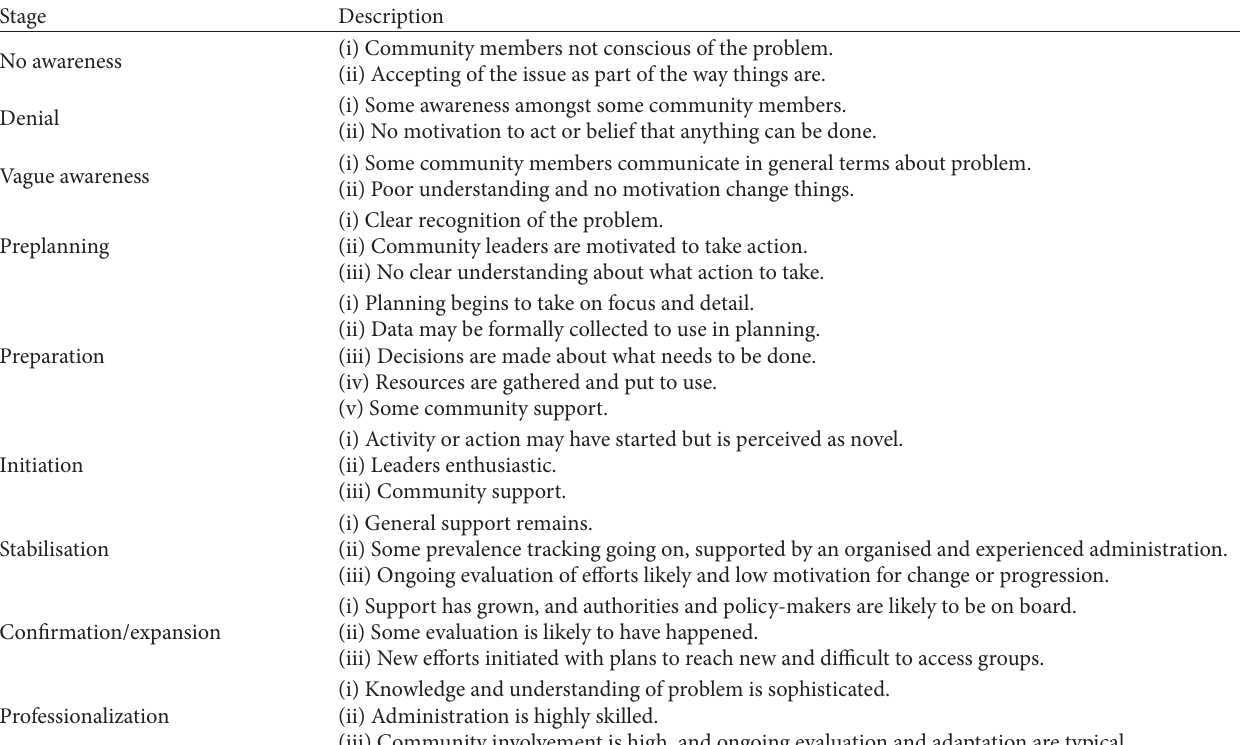
Table 1: Stages of community readiness model (adapted from Edwards et al.